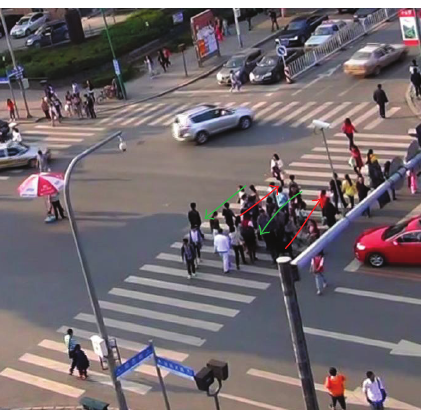
Figure 8: Lane formation in bidirectional pedestrian